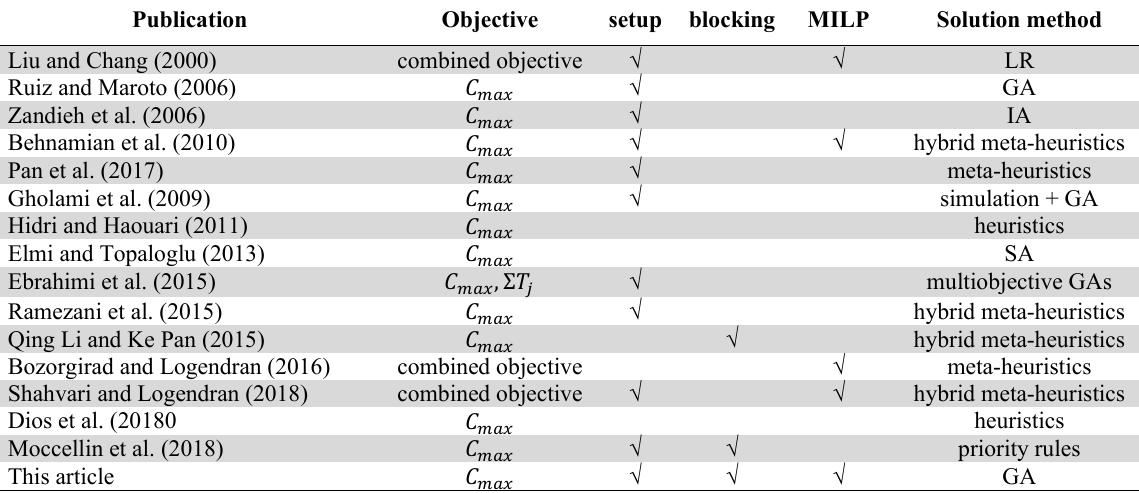
Related approaches to the variant under